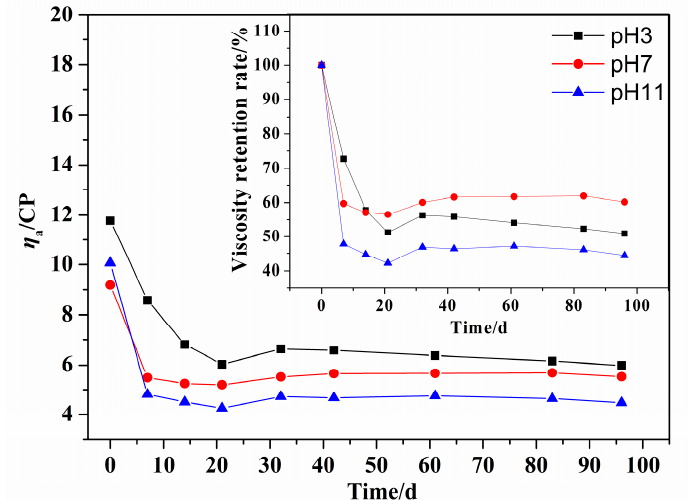
Figure 11. Effect of pH on the η a of PDMC solution.